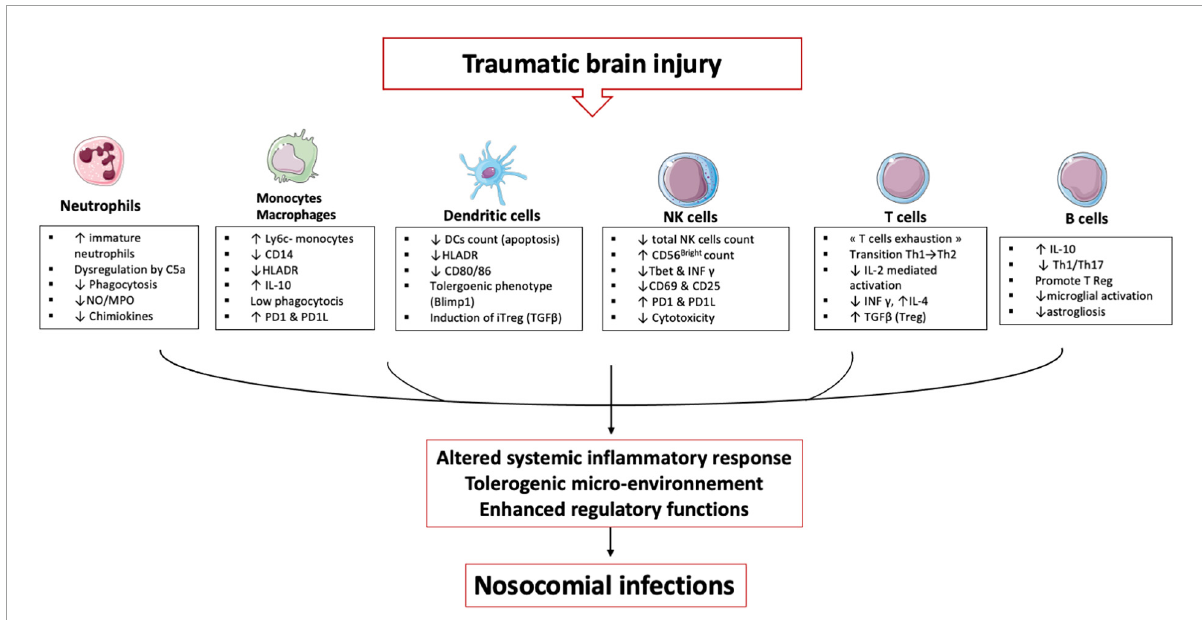
FIGURE3 TBI induces alterations in immune cells: These immune alterations concern myeloid and lymphoid cells, starting in the bone marrow and lymphoid organs and then in the circulating cells. It is an alteration of the first line of defense (neutrophils) and an inability of the monocyte & macrophages to maintain the inflammatory response. Dendritic cells lose their ability to present antigen and secrete pro-inflammatory cytokines. All these cells develop a tolerogenic phenotype unable to initiate the lymphocyte response, which leads to an expansion of regulatory T cells. All these mechanisms induce a phenomenon called post-traumatic immunodepression and favors the occurrence of nosocomial